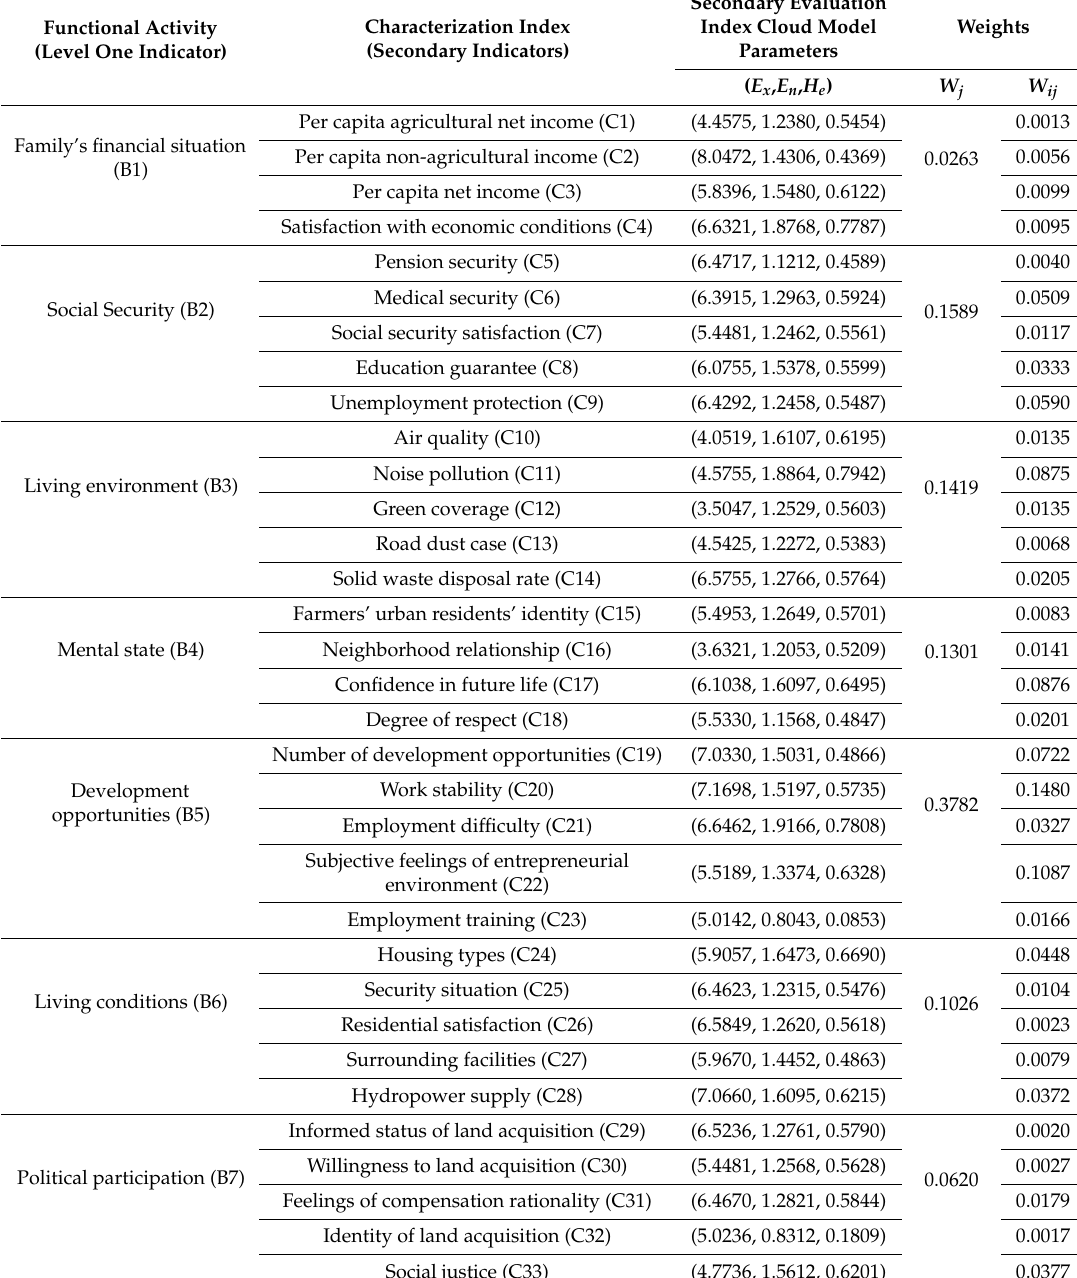
Table A2. The weight of the secondary evaluation index and the cloud model parameters of the welfare e ff ect of the asset-balanced land-lost farmers’